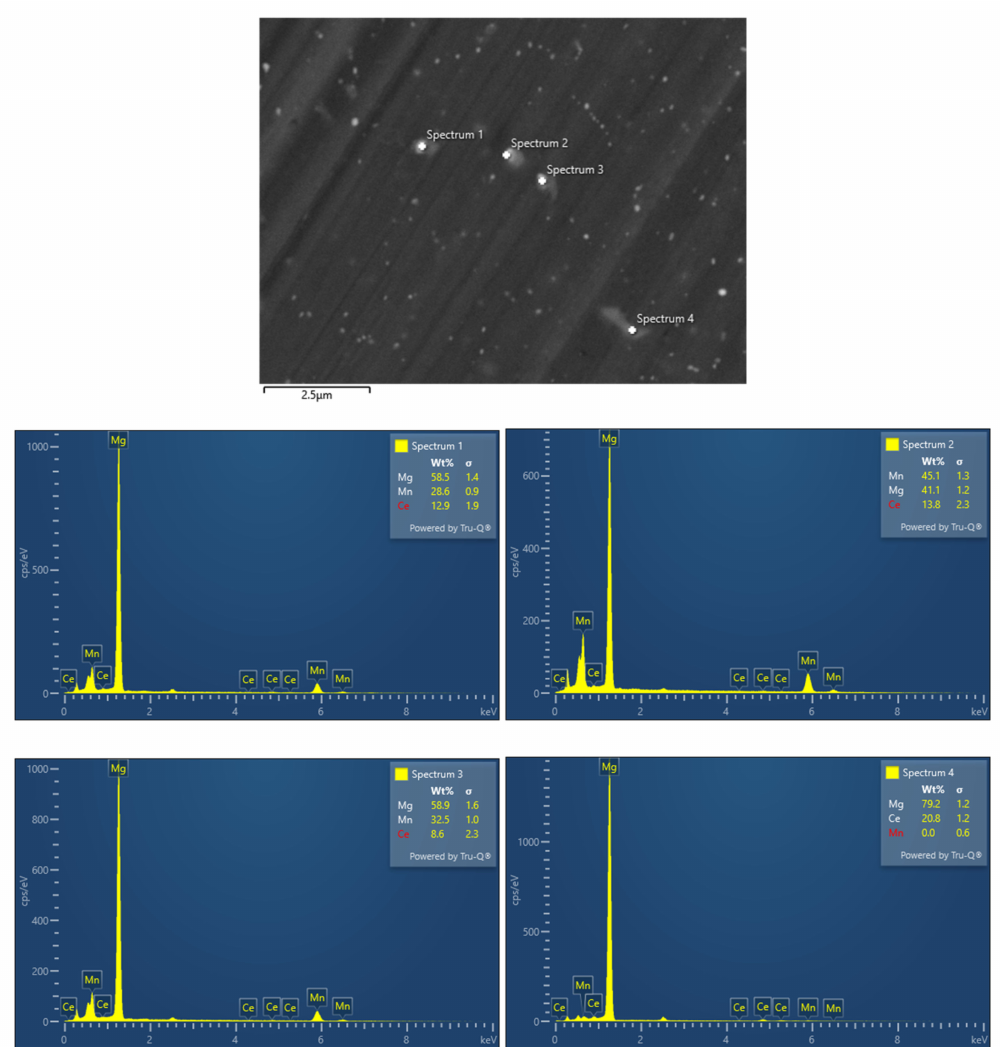
Figure 11. SEM examination of the precipitates in the Mg-1.9Mn-0.3Ce